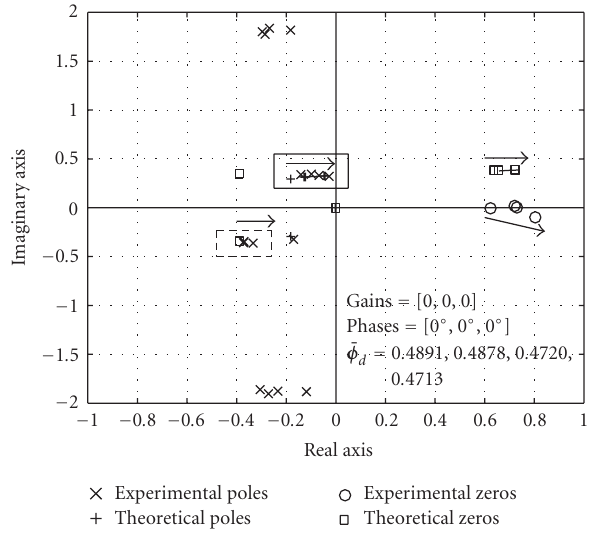
Figure 9: Open-loop root locus for harmonic 1 with varying flow coe ffi cient.